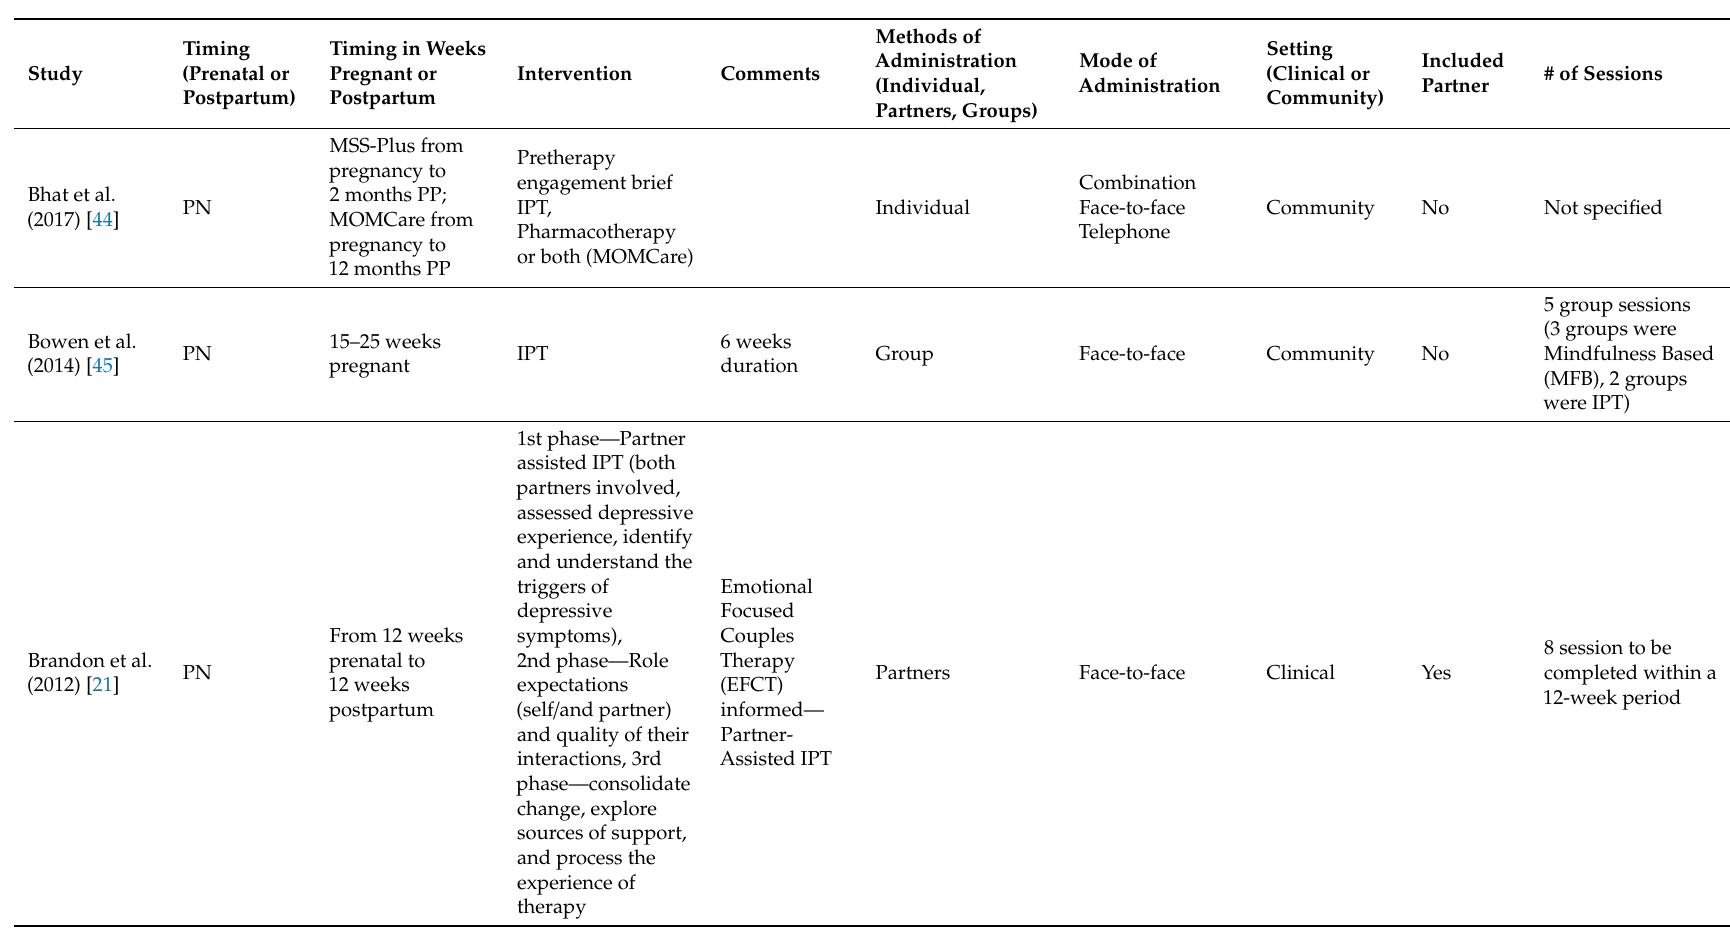
Table 2. Characteristics of